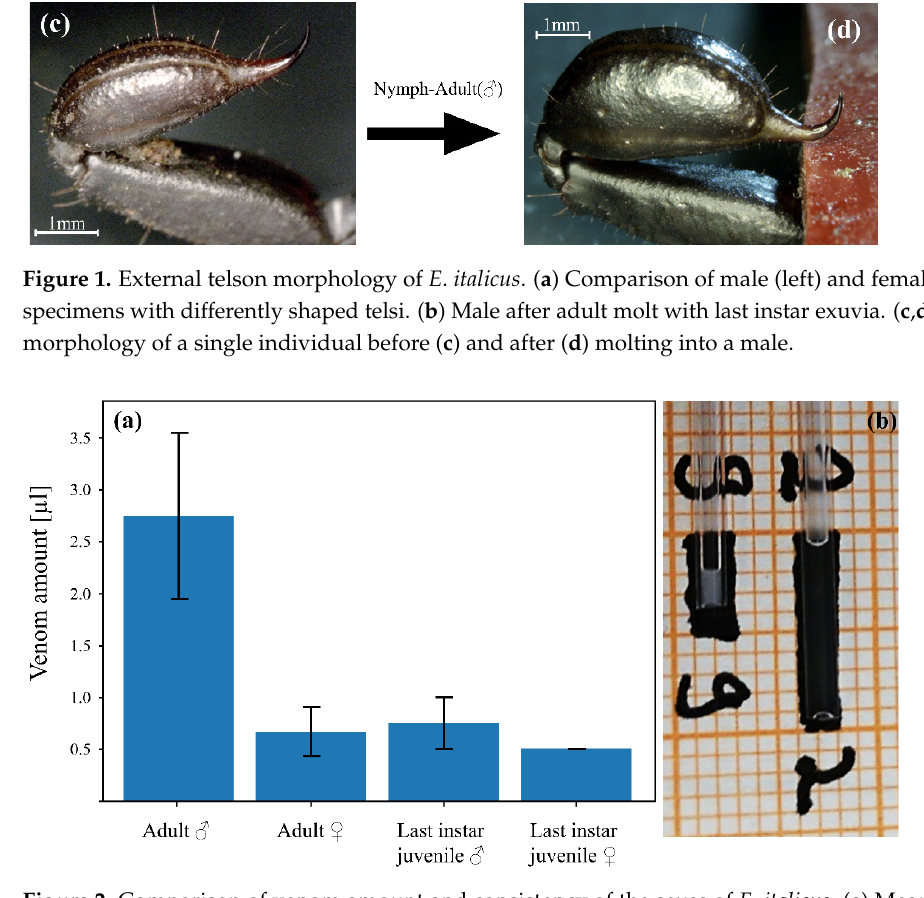
Figure 2. Comparison of venom amount and consistency of the sexes of E . italicus . ( a ) Mean venom amount (error bars represent standard deviation) released by adult males (6 extractions; 2 speci- mens), adult females (12 extractions; 4 specimens), and juveniles (12 extractions; 4 specimens) dur- ing venom extraction. The values are based on three repeated extractions per specimen with an interval of one week between the extractions. ( b ) Venom consistency in males (right capillary; trans- lucent) and females (left capillary; milky).